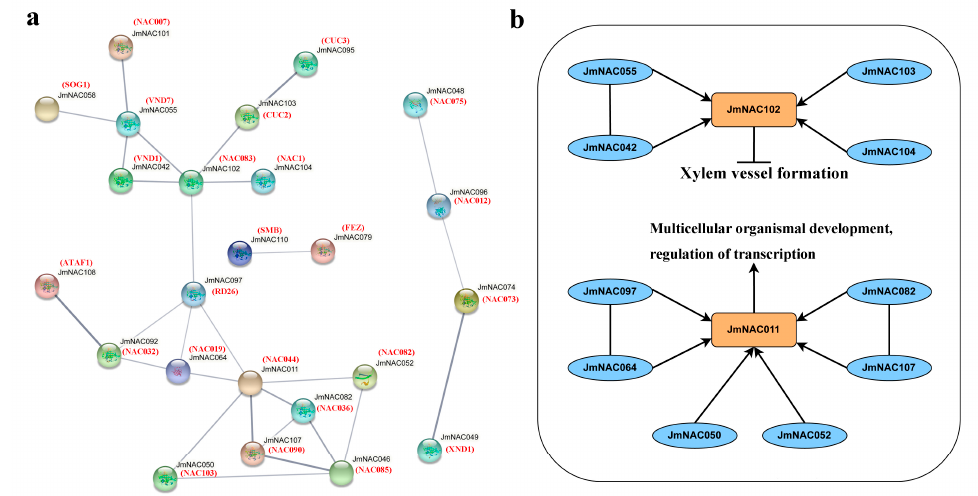
Figure 4. Functional network of JmNAC genes. ( a ) Network of JmNAC genes in J. mandshurica based on the orthologues in A. thaliana . ( b ) A schematic representation of a regulatory network among JmNAC genes.